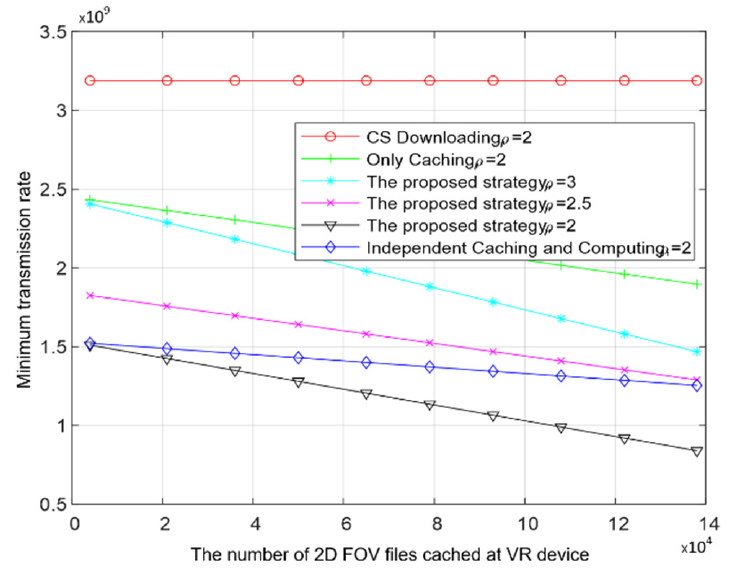
Figure 3. The effect of Q D on R with different ρ values and comparison with other schemes.